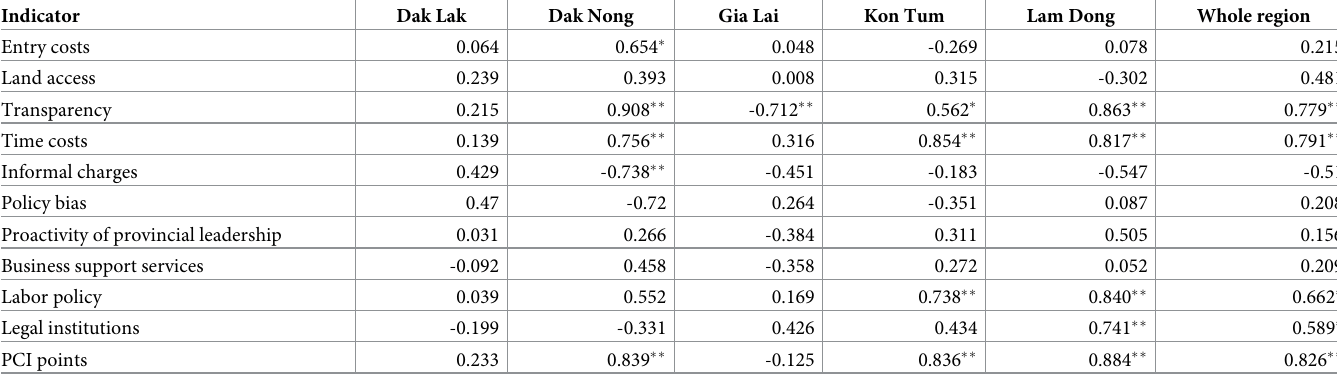
Table 6. Correlation between PCI and the number of labor of enterprises in the Central Highlands in the 2006–2018 period. Indicator